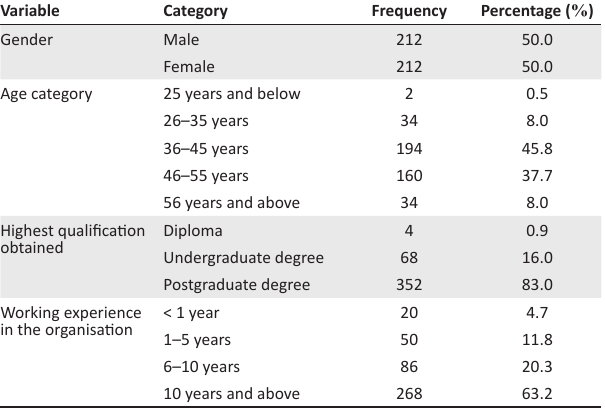
TABLE 1: Characteristics of the respondents ( n = 424).